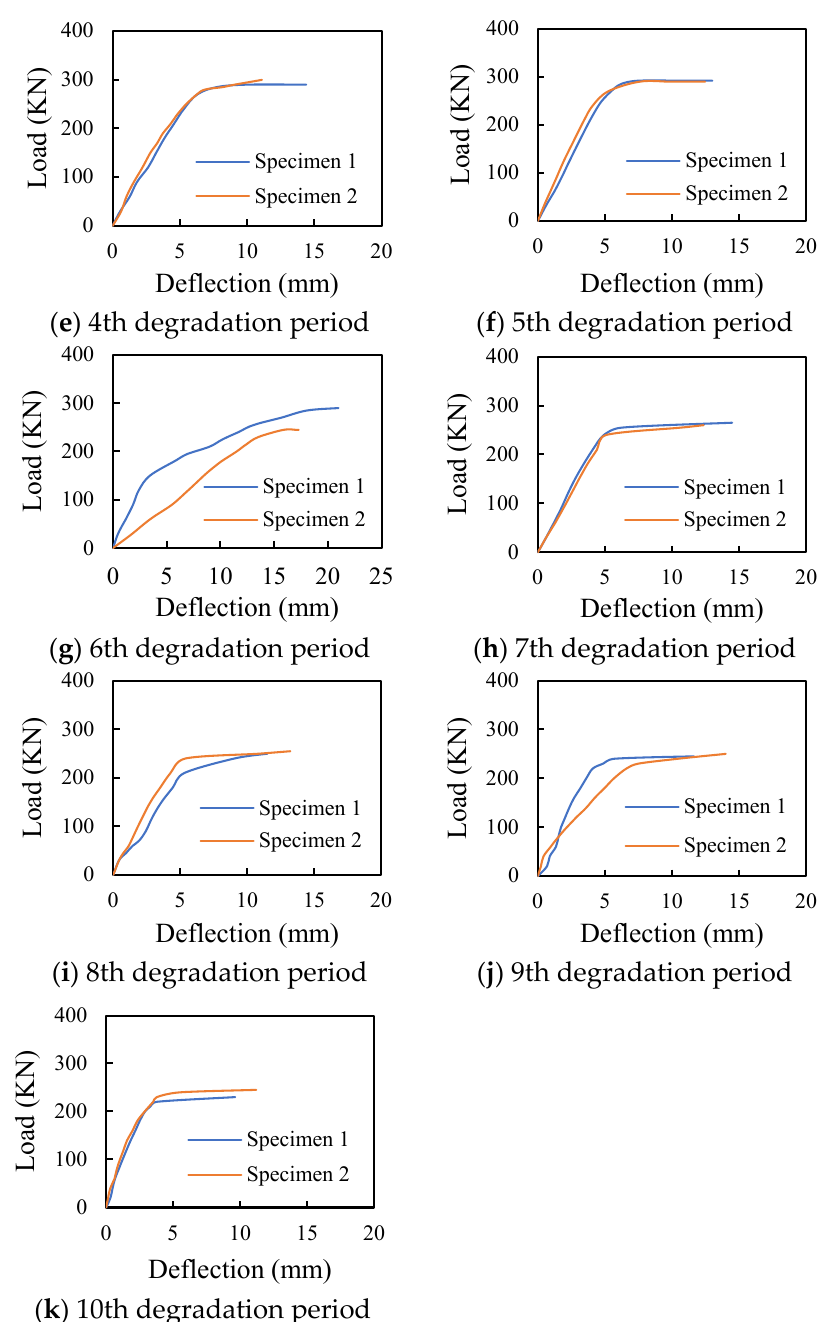
Figure 13. Load versus mid-span deflection relationship in the degradation periods 0–10: ( a ) 0 degradation period to ( k ) 10th degradation period.